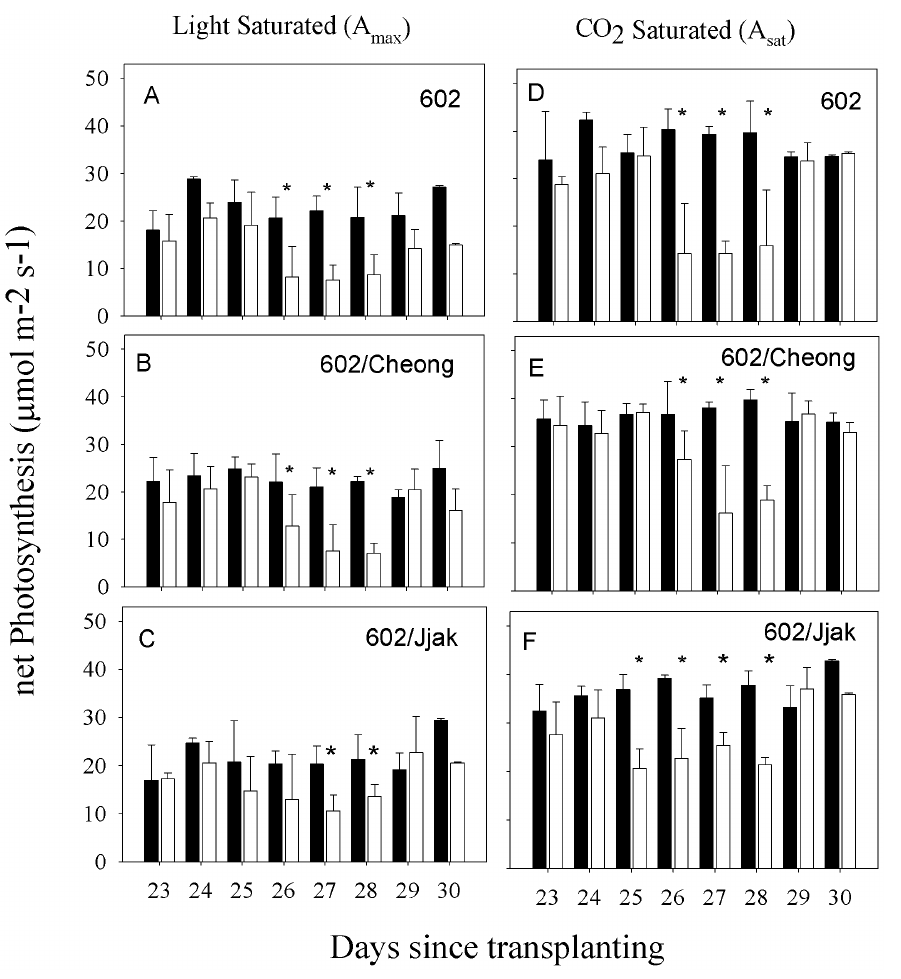
Fig. 5. Mean midday light saturated net photosynthesis (A, B, C) and CO 2 saturated net photosynthesis (D, E. F) for three lines of tomato grown with daily watering (filled bars) or daily watering until water was withheld between day 20 and day 28 (open bars). 602 5 ‘BHN 602’; 602/Cheong 5 ‘BHN 602’ scion grafted onto ‘Cheong Gang’ rootstock; 602/Jjak 5 ‘BHN 602’ scion grafted onto ‘Jjak Kkung’ rootstock. Error bars represent two standard errors on each side of the mean. * 5 significant difference between control and mild-drought treated plants within a plant type (Student’s t-test; p , 0.05).